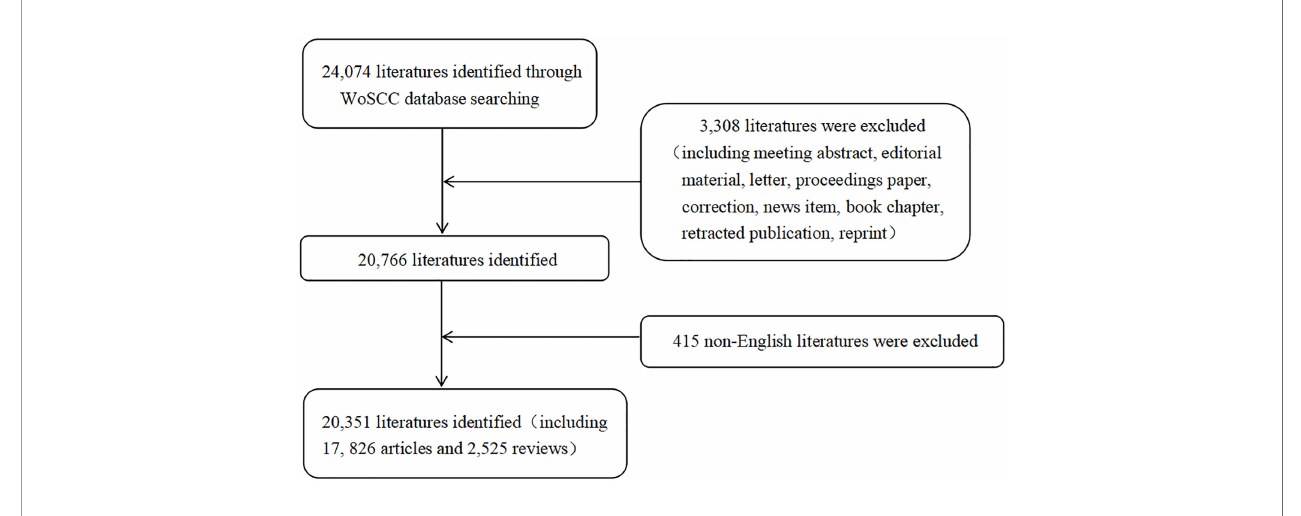
FIGURE 1 | Flow chart of literature collecting.